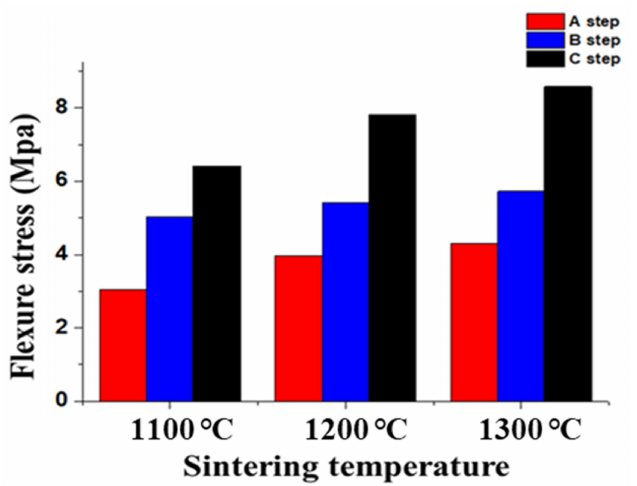
Figure 8. Bending strength of ceramics sintered at different temperatures with A, B, and C debinding